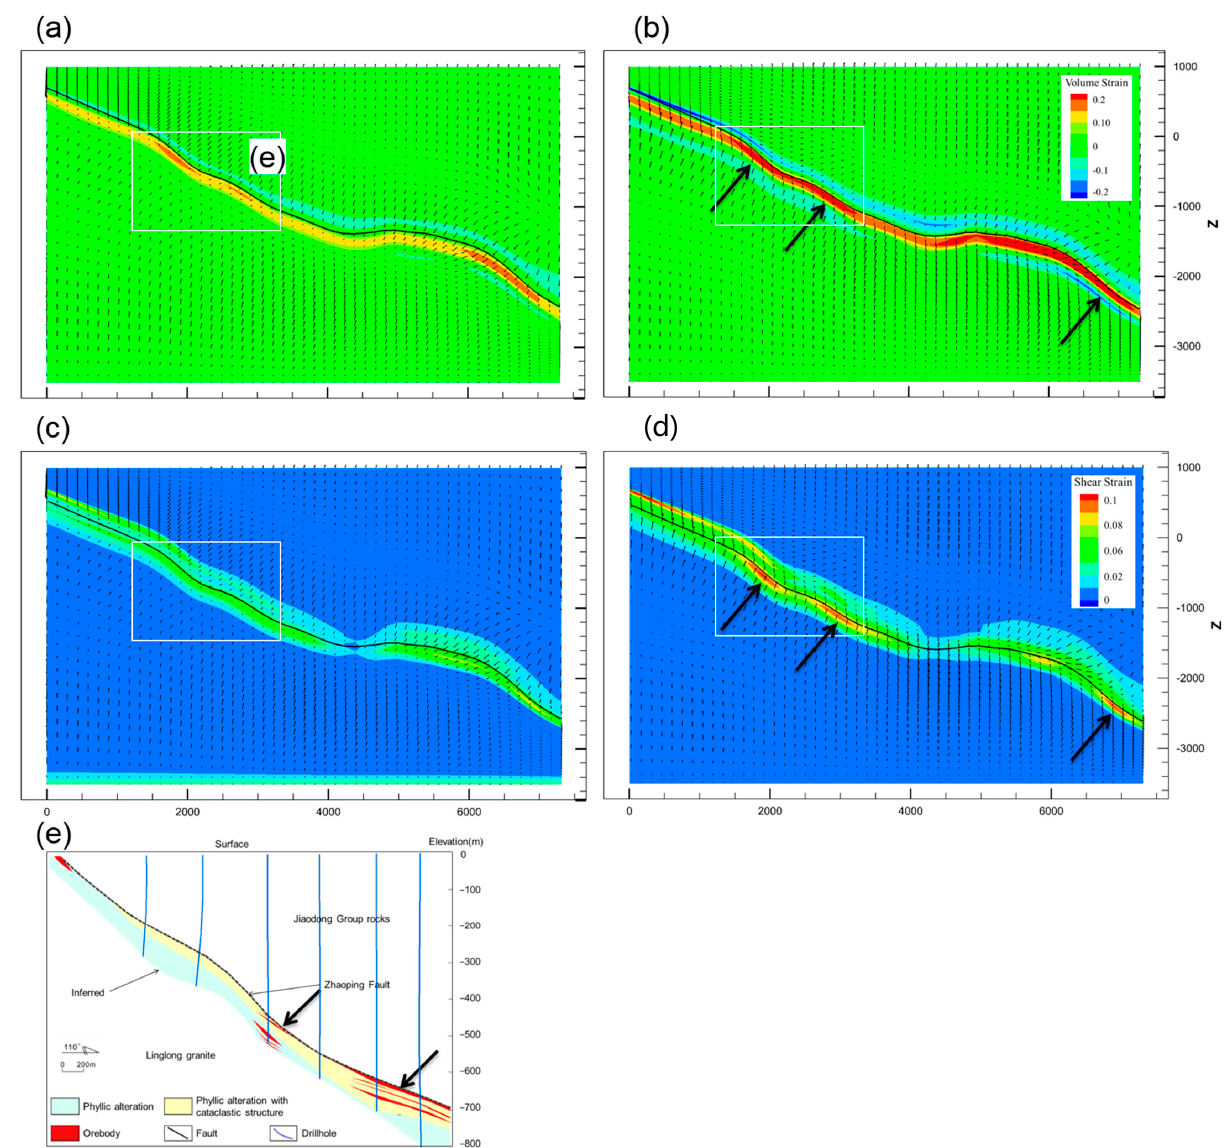
Figure 10. The volumetric strain, shear strain distribution, and detailed fluid flow vectors at a strain rate of 10 − 11 s − 1 . In the figure, the rectangular box is the scope of the cross-sections; thick arrows indicate areas of intense strain or mineralization; the vector arrows represent the Darcy flux and are used to indicate the direction of flow. ( a ) 0.5% volumetric strain, ( b ) 1.0% volumetric strain, ( c ) 0.5% shear strain, ( d ) 1.0% shear strain, and ( e ) corresponding geological